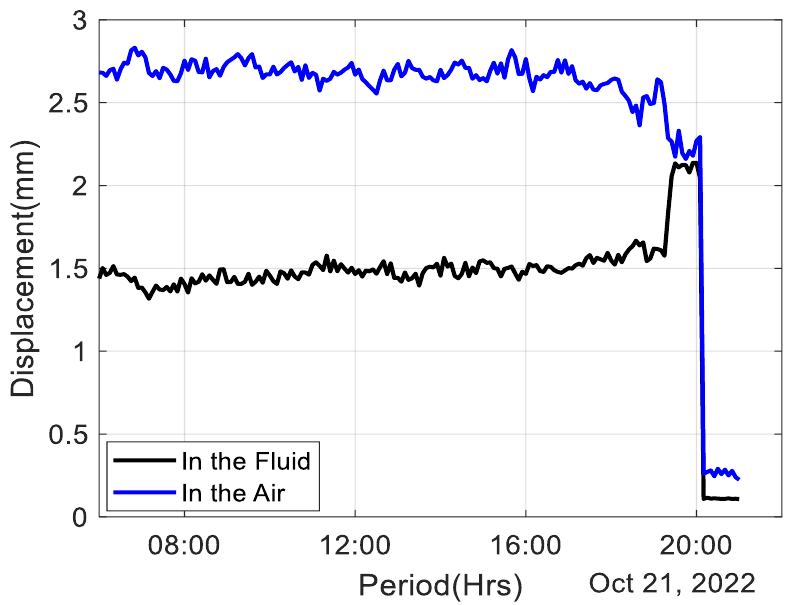
Figure 21. The overall trend of the drill string vibration level. The blue line shows the transient contact in the air with a coefficient of friction µ = 0.2, and the black line shows the frictional contact inside the fluid with the same coefficient of friction.